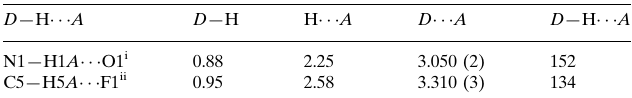
Hydrogen-bond geometry (A˚ , (cid:1) ).